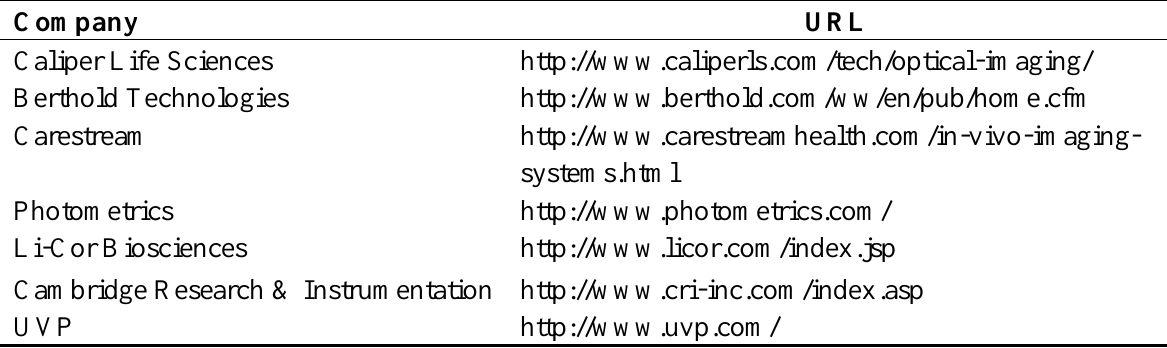
Table 2. Commercial manufacturers of in vivo imaging